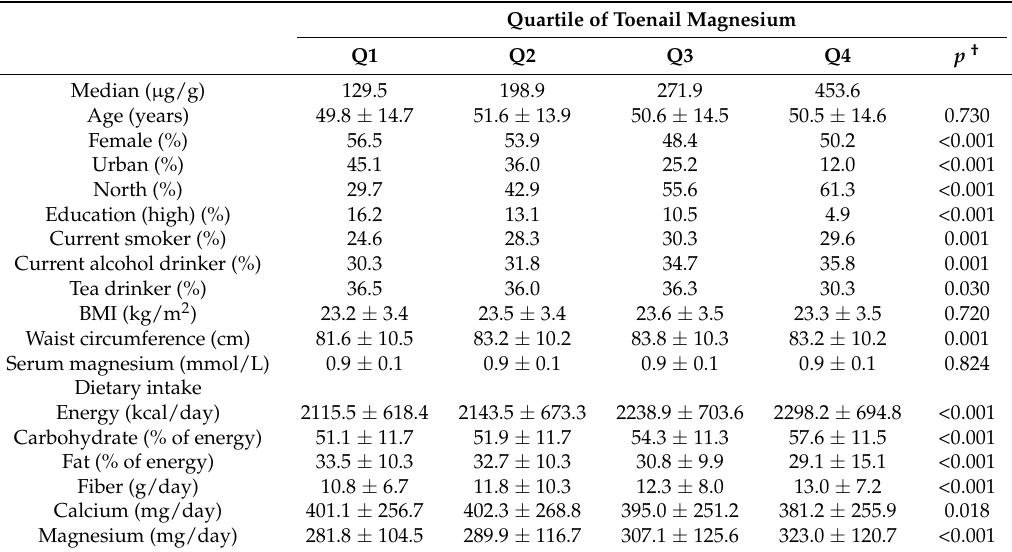
Table 2. Characteristics of the study population according to quartiles (Q) of toenail magnesium *.